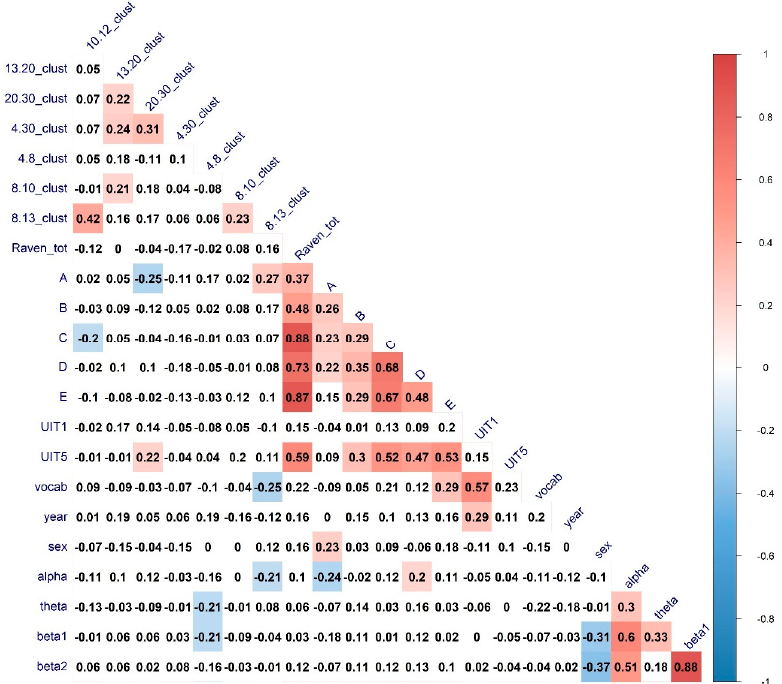
Figure 3. The heatmaps of the correlations between cognitive abilities measures, cluster coefficient, sex, age, and EEG Frequency bands power. Correlations of significance level p < 0.05 are marked in color. Clust—Coefficient of the clusterization; UIT1—“Awareness” verbal subtest, UIT5—“Conclusion” subtest of the Universal Intellectual Test, vocab—“MyVocab” test. The results are adjusted for multiple comparisons with the FDR